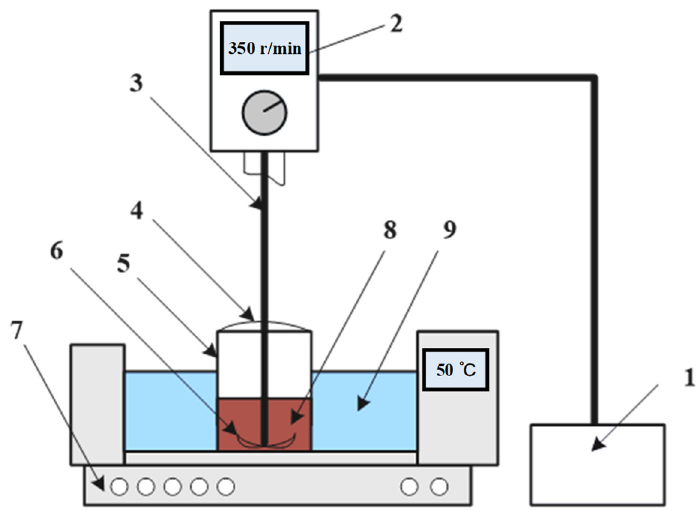
Figure 2. Schematic diagram of leaching experiment equipment. 1—Frequency converter stirrer bracket. 2—Agitator. 3—Stainless steel impeller. 4—Plastic film. 5—Beaker. 6—Stirring blades. 7—Constant temperature water bath. 8—Sample and ammonia mixture. 9—Constant temperature flume.